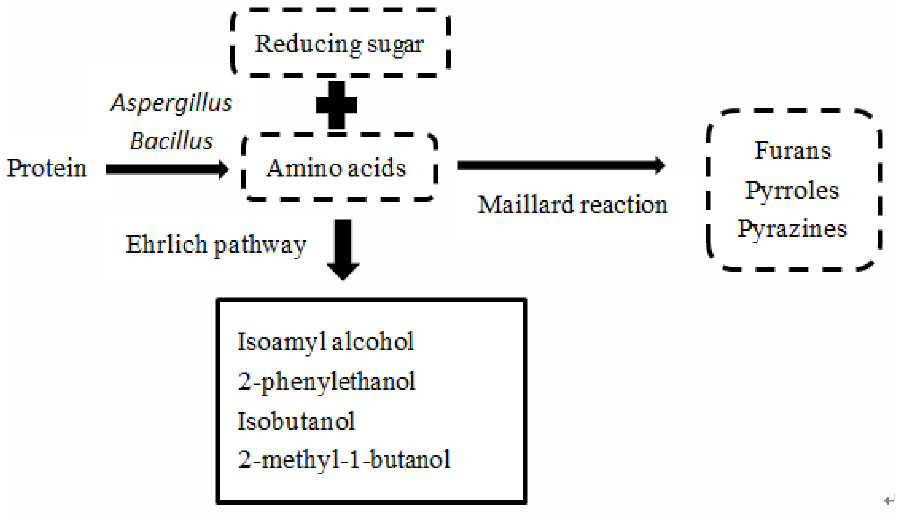
Figure 3. Key — transformations of protein and the formation of sauce aroma. Figure 3. Key—transformations of protein and the formation of sauce